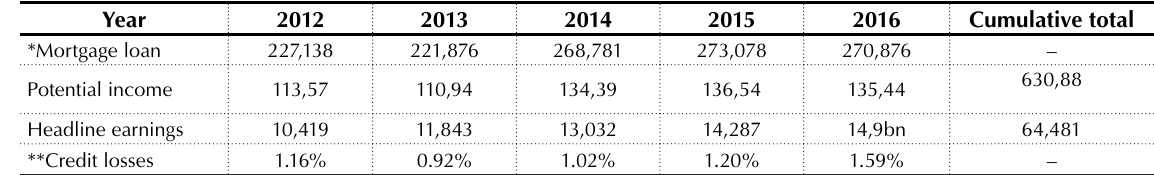
Table 2. Bank B potential BASF income as a function of mortgage loans and credit losses